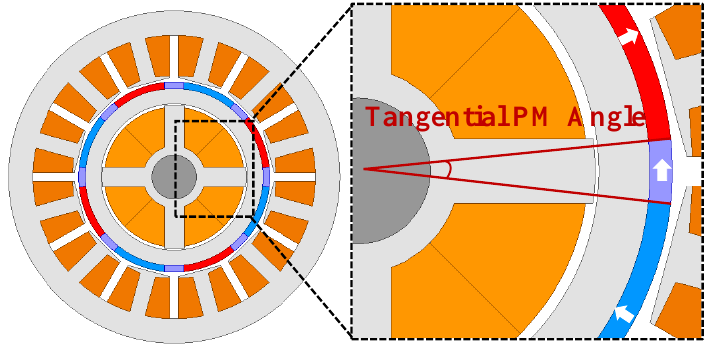
Figure 11. Rotor variable for tangential PM angle.